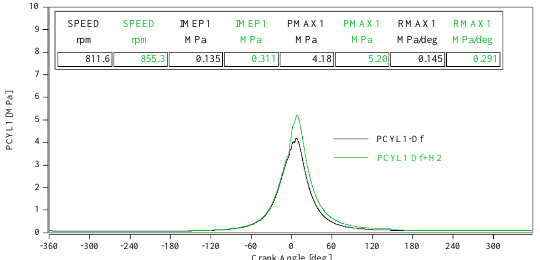
Fig. 5. Pressure inside the combustion chamber for idle operation, with diesel (black colour), diesel and H (green colour), additionally the table shows the average index pressure (IMEP1), maximum combustion pres- sure (PMAX1), maximum pressure rise speed (RMAX1) and engine speed (SPEED)